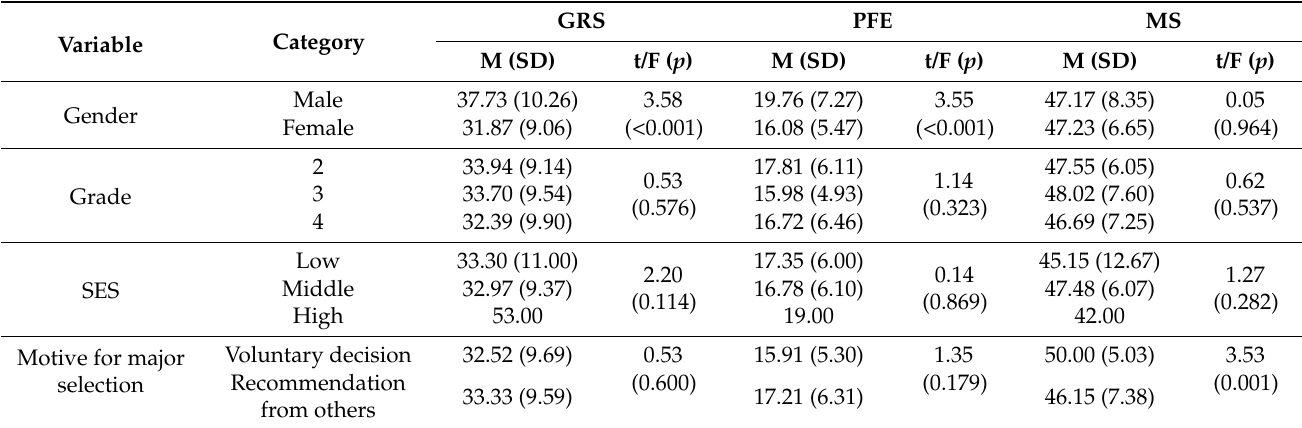
Table 2. Gender role stereotypes, patriarchal family environment, and major satisfaction (MS) according to participants’ general characteristics ( n = 195).